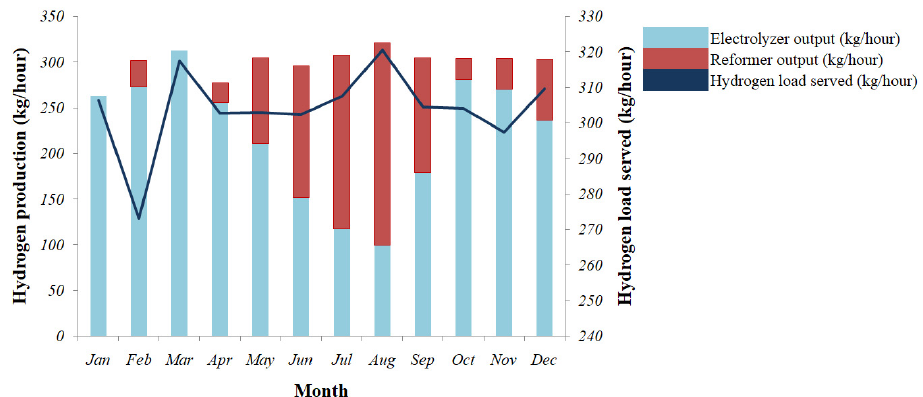
Figure 15. Monthly average electricity production by HEGS combination 3.